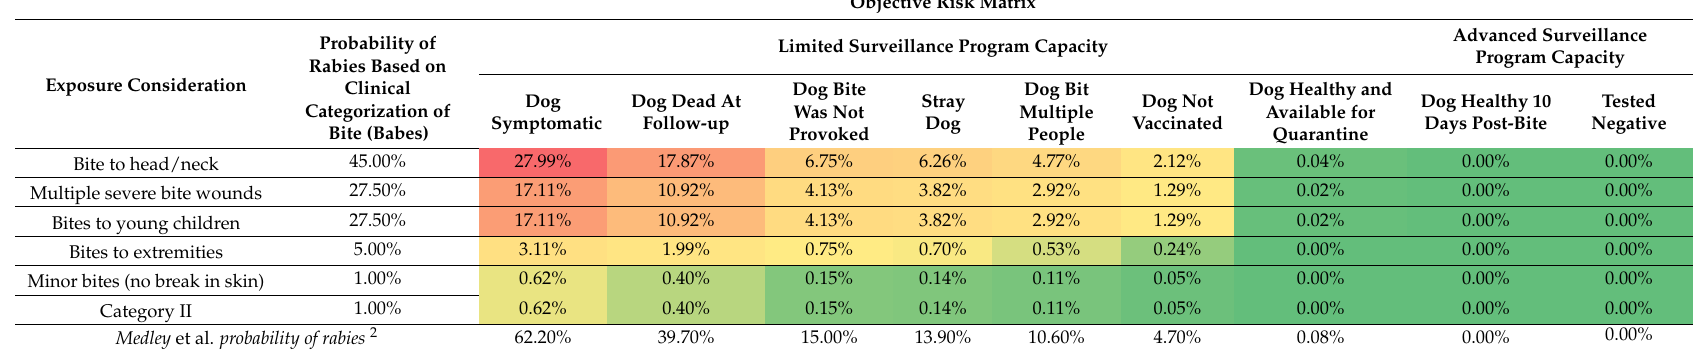
Table 4. Risk matrix 1